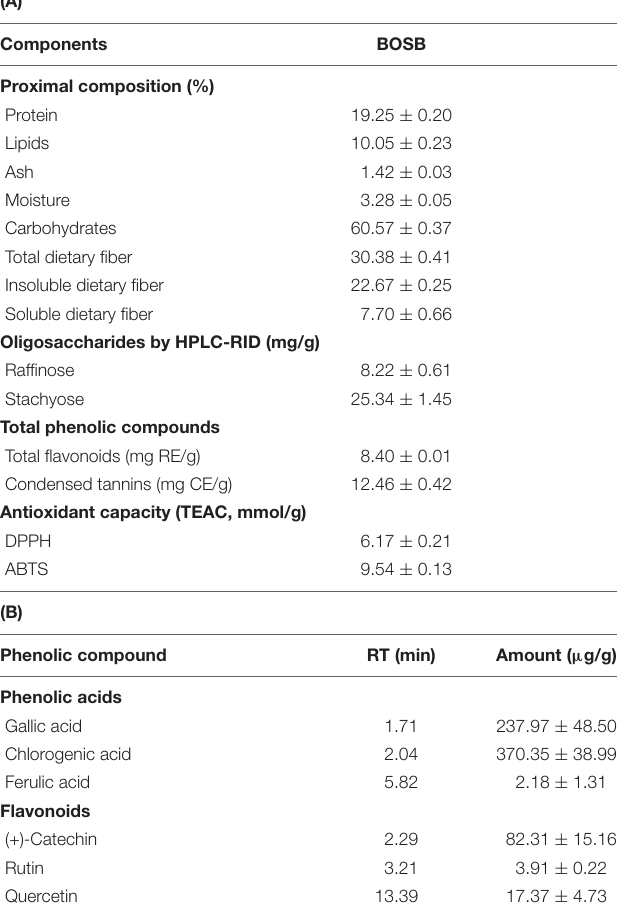
TABLE 1 | Chemical and nutraceutical composition of BOSB. (A) Proximal composition, oligosaccharides, total phenolic compounds, and antioxidant capacity; (B) Free phenolic compounds quantified by